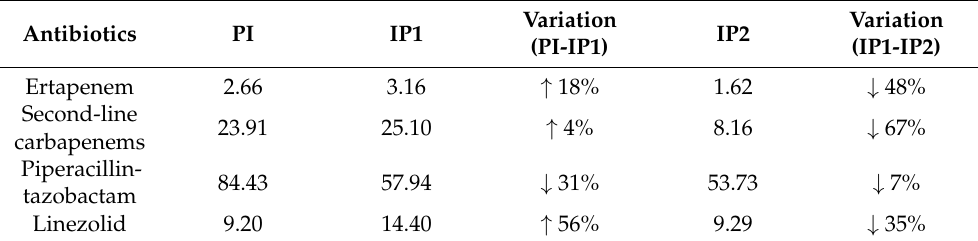
Figure 4. Antibiotic DDD 1 adjusted per discharges, showing Pre-intervention Period and the two Intervention periods. 1 DDD: Defined Daily Dose; PI: Pre-intervention Period; IP1: Intervention Period 1; IP2: Intervention Period 2. Table 2. Antibiotic DDD 1 adjusted per discharges. Analysis of the variations among Pre-intervention Period and the two Intervention periods.